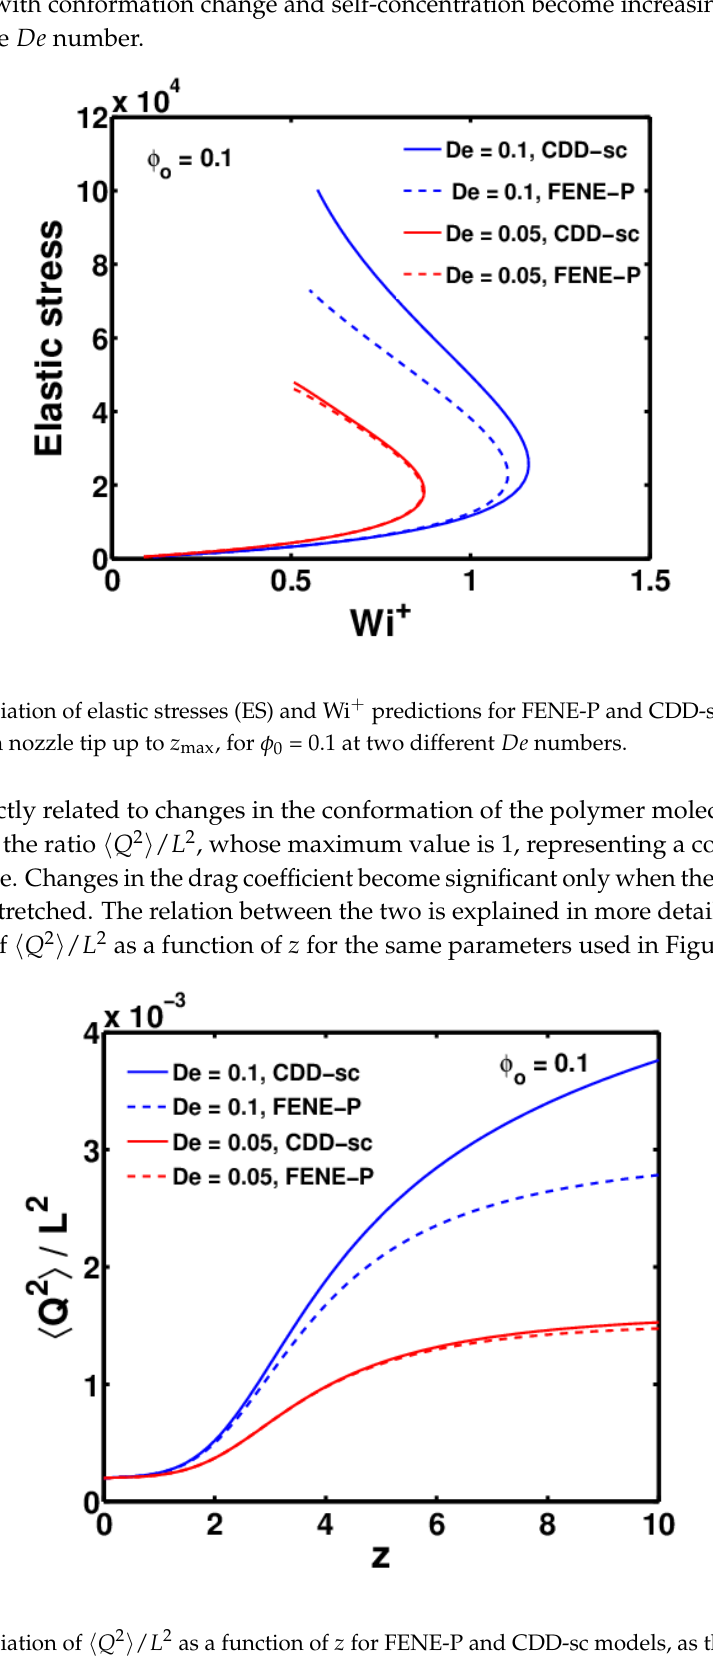
Figure 8. Variation of (cid:104) Q 2 (cid:105) / L 2 as a function of z for FENE-P and CDD-sc models, as the jet thins from nozzle tip up to z max , for φ 0 = 0.1 at two different De